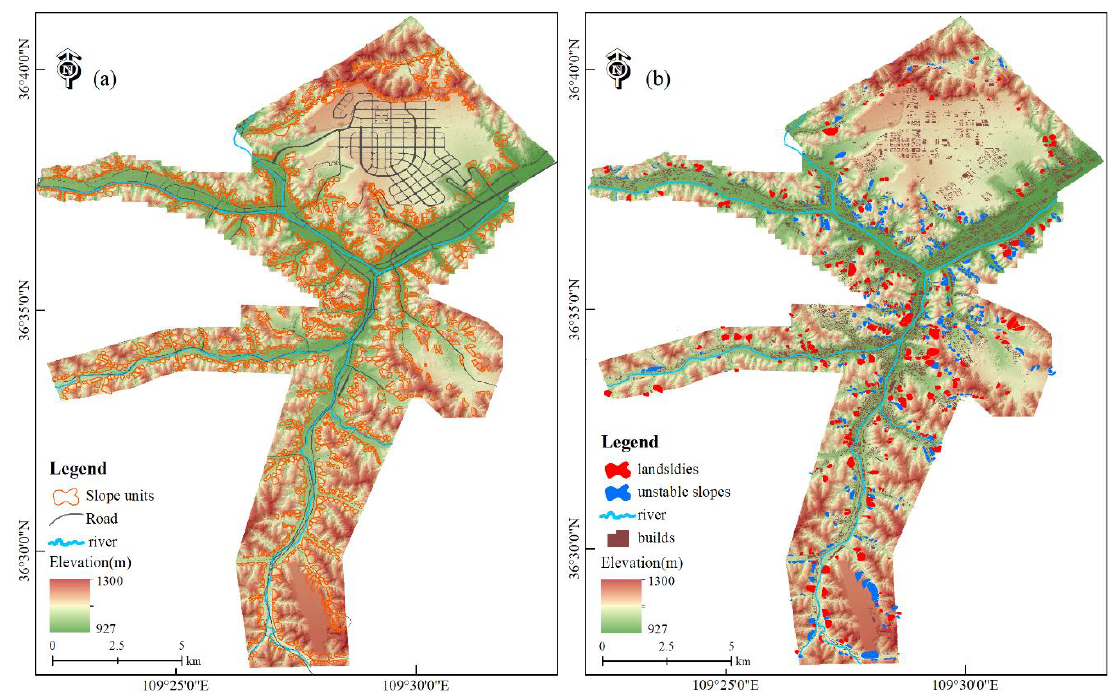
Figure 3. The inventory map of the present study. ( a ) Slope unit mapping and road elements based on topography and field surveys. ( b ) The distribution of landslides and unstable slopes in the study area.